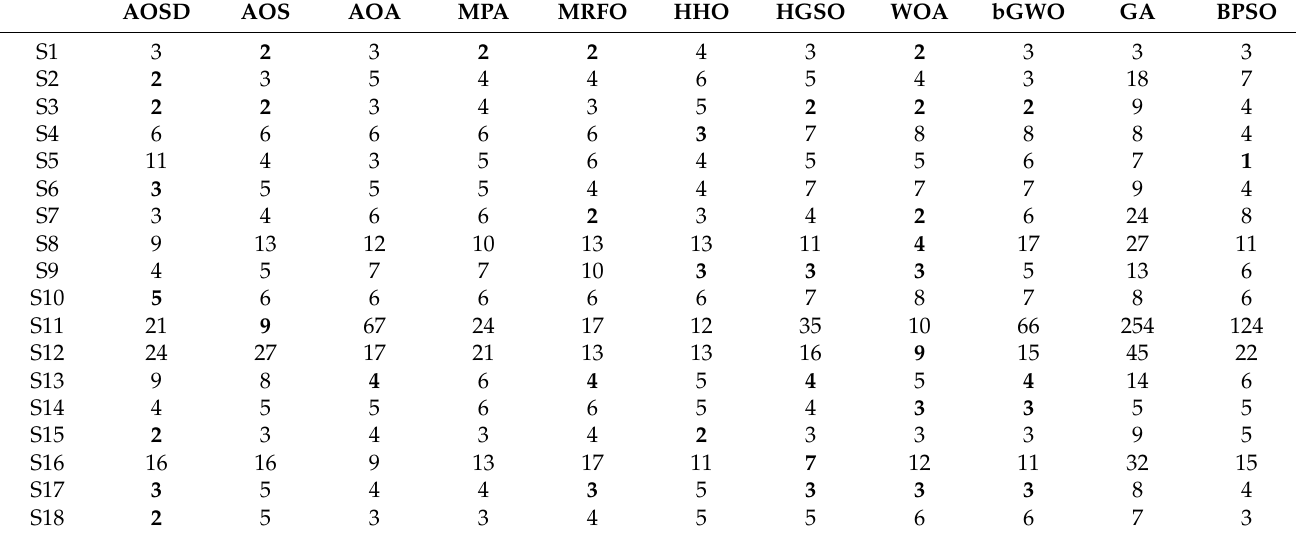
Table 7. Selected features numbers for FS approaches.